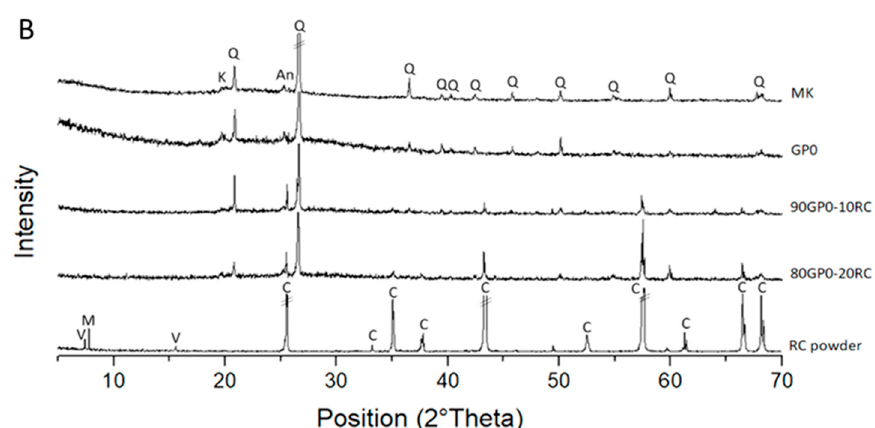
Figure 4. ( A ) XRD patterns for RC raw materials MK, GP-10RC, and GP-20RC recycled corundum- based geopolymers. ( B ) XRD patterns for RC raw materials MK, 90GP0-10RC, and 80GP0-20RC. Crystalline phases identification labels: Q = alpha-quartz (01-083-0539), K = kaolinite (01-075-0938), C = corundum (01-071-1124) An = anatase (01-071-1167), M: montmorillonite (00-012-0232), V: valleriite (01-073-0516).